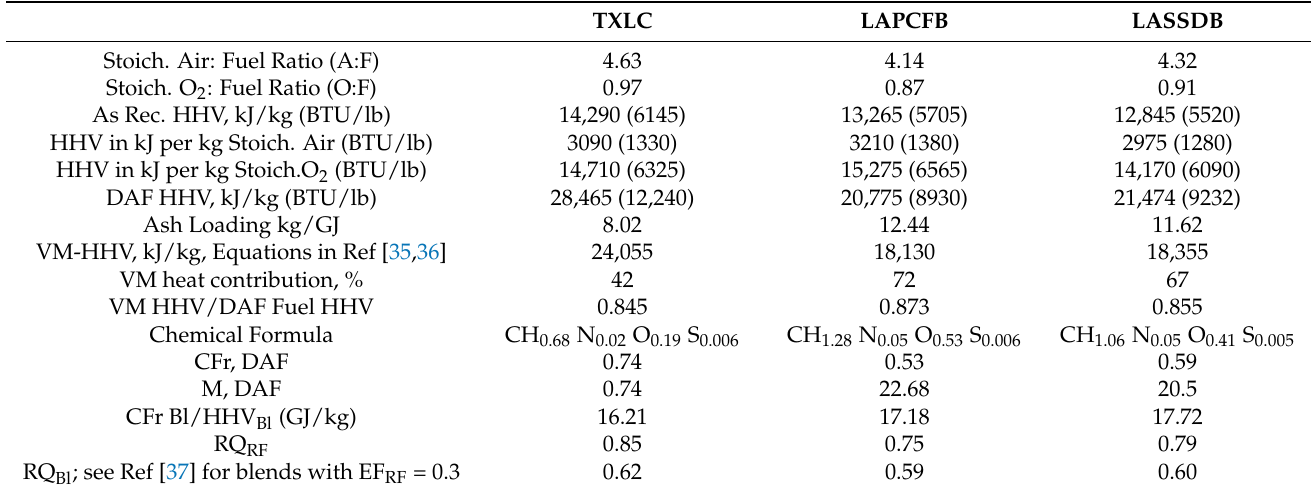
Table 3. Derived fuel properties for reburn fuels.